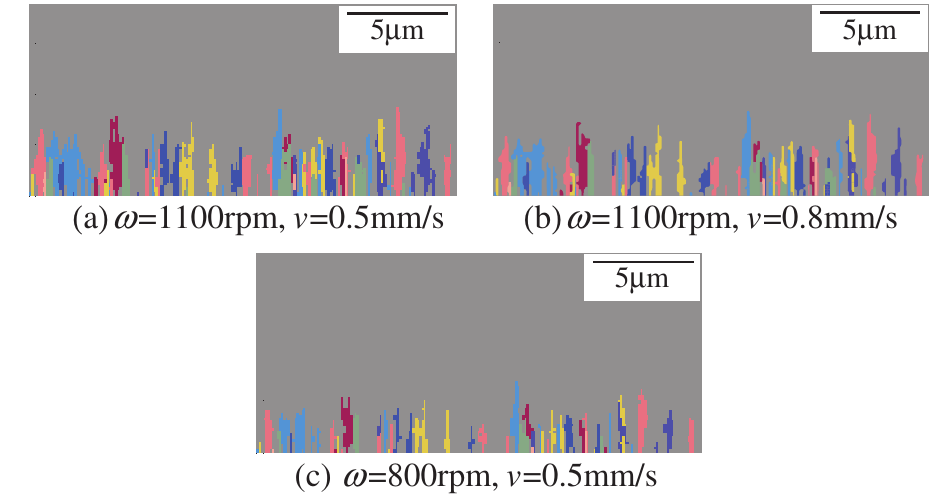
Figure 14: Formation of acicular α phase morphology in 750°C in different welding conditions.